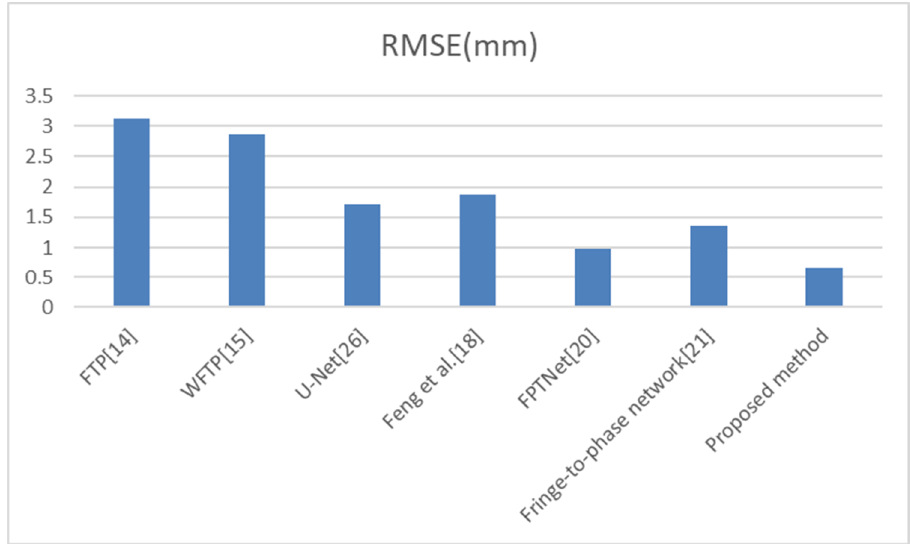
Figure 13. Comparison with different single-shot methods.